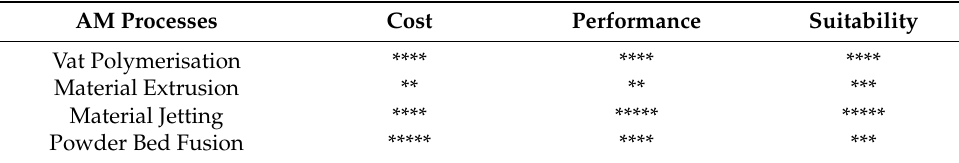
Table 3. Suitability Matrix for various AM processes for low-cost robotics application.